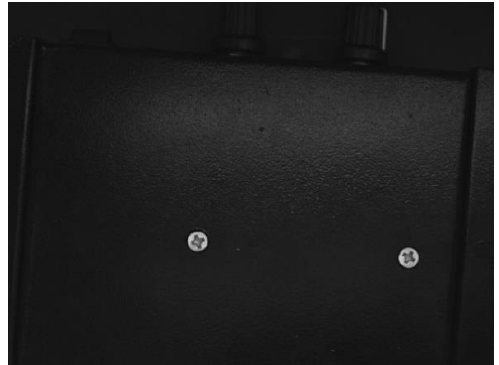
Figure 9. Original image captured by the camera.